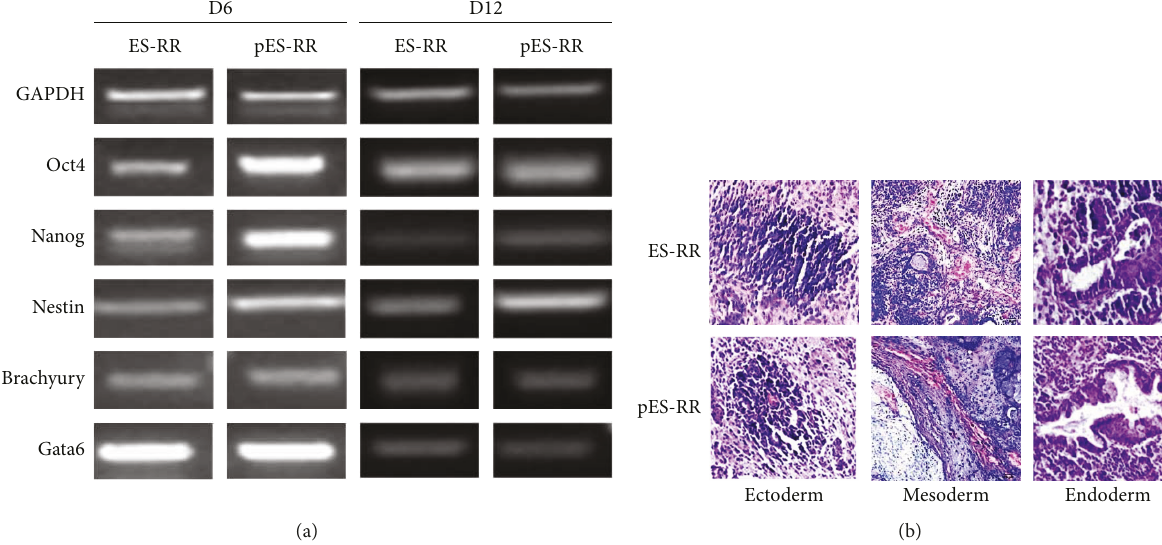
Figure 5: Di ff erentiation potential between two cell lineages. (a) RT-PCR analysis of the expression of stemness-related genes of EBs from two groups in D6 and D12, which displayed no signi fi cant di ff erence. (b) Teratoma formation of pES-RR and ES-RR. Histological analysis of teratoma identifying the presence of derivatives of all three germ layers: neural tissue (ectoderm), vascular tissue (mesoderm), and glandular tissue